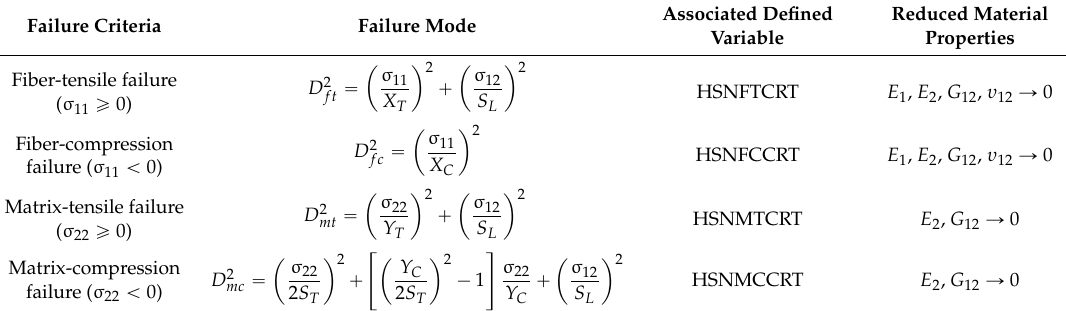
Table 4. General formulation of 2D Hashin damage criteria for the CFRP phase